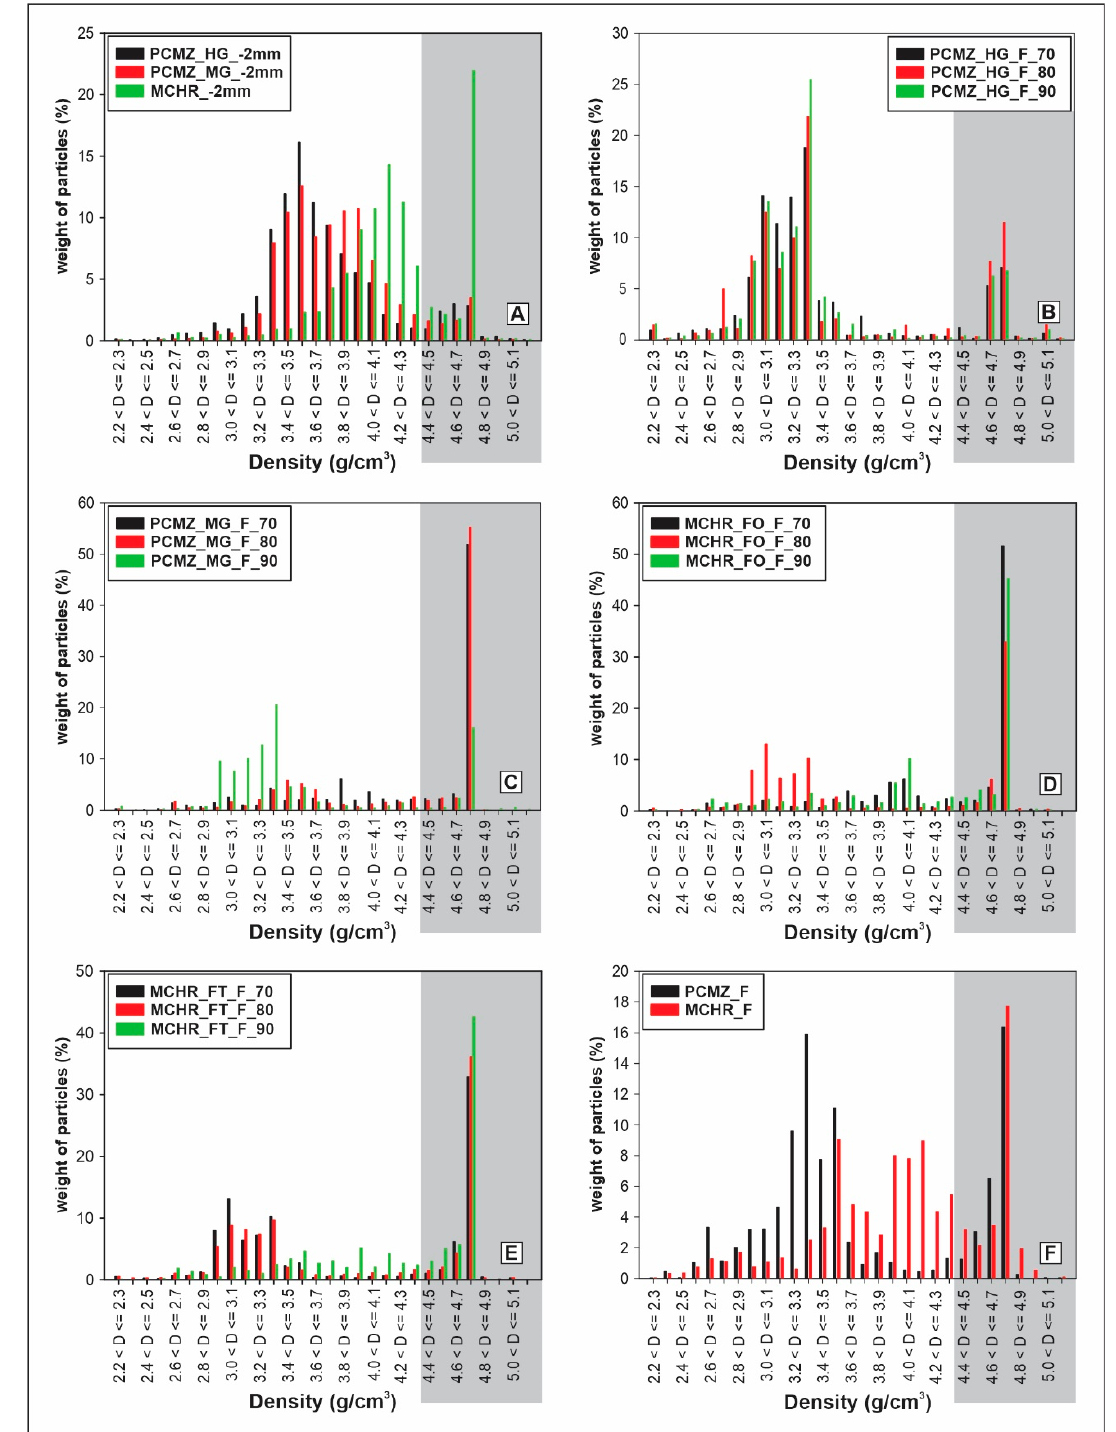
Figure 8. Particle density distribution plots for the feed samples. ( A ) − 2 mm crush. ( B ) PCMZ_HG. ( C ) PCMZ_MG. ( D ) MCHR_FO. ( E ) MCHR_FT. ( F ) PCMZ and MCHR samples from the concentrator plant. The grey shaded areas represent the chromite population. The tailings also contained considerable abundances of chromite which ranged from 15% in the PCMZ to 18% in the MCHR samples from the plant (Figure 9).